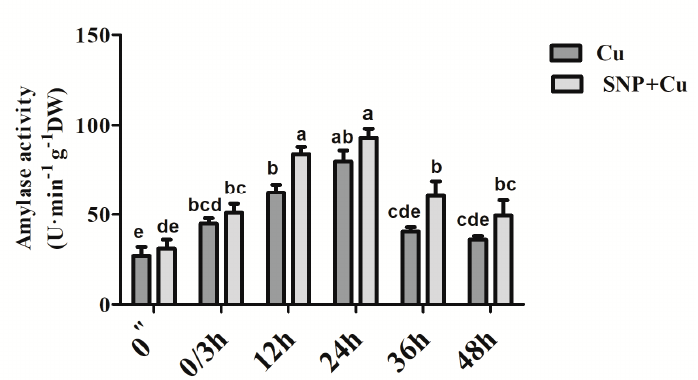
Figure 6. Activity of amylase in germinating seeds of Indian mustard ( Brassica juncea L.) pre-treated with water or 100 µM SNP for 3 h (shown as from 0” to 0/3 h of the treatment times) prior to exposing to 3.0 mM Cu for further 48 h (shown as 3/0, 12, 24, 36 and 48 h respectively). Same letters above bars show that data did not differ significantly by LSD test at p < 0.05. DW—dry weight.